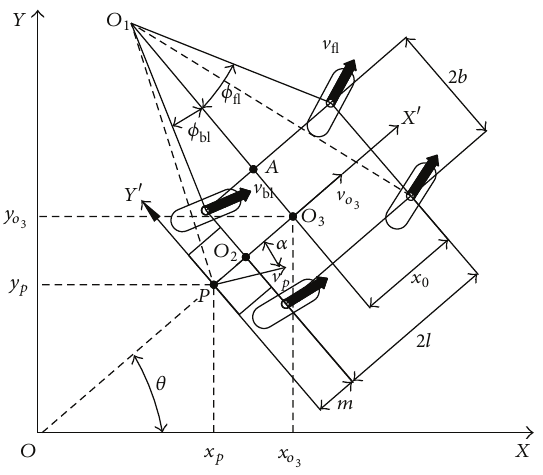
Figure 4: Schematic diagram of four-wheel steering mode.